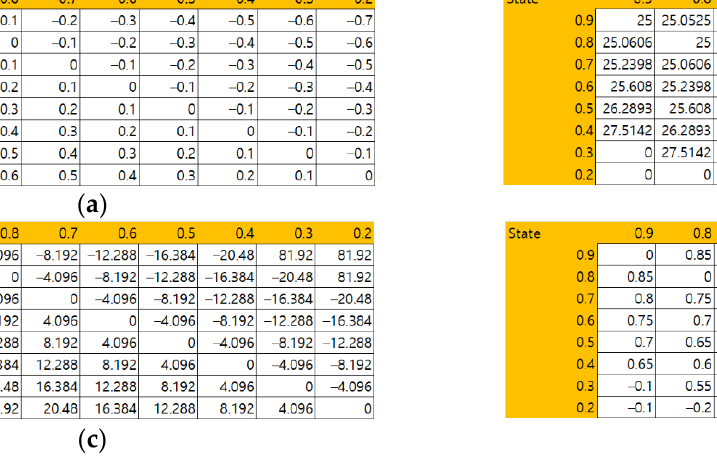
Figure 8. ( a ) Table configured for cycle depth; ( b ) Table configured for temperature; ( c ) Table configured for ESS output; ( d ) Table configured for average SOC.